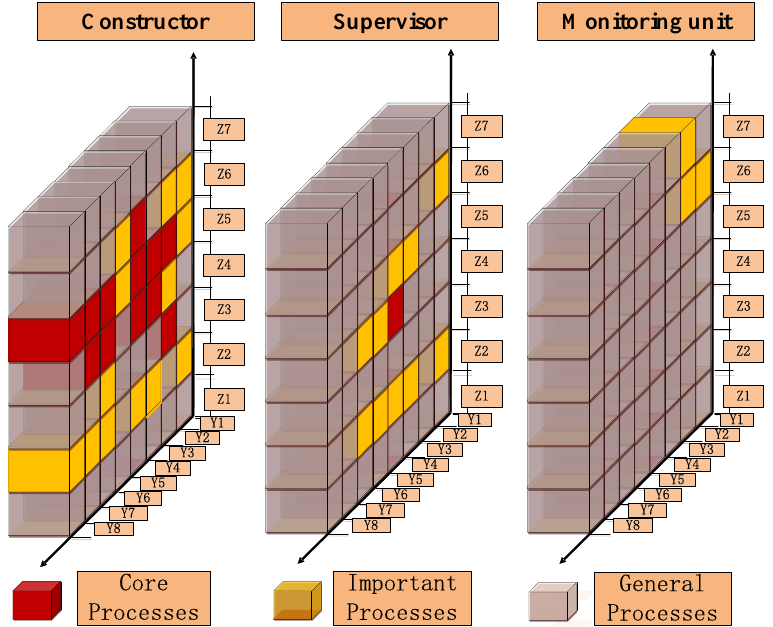
Figure 9. Importance degree of safety risk management processes.